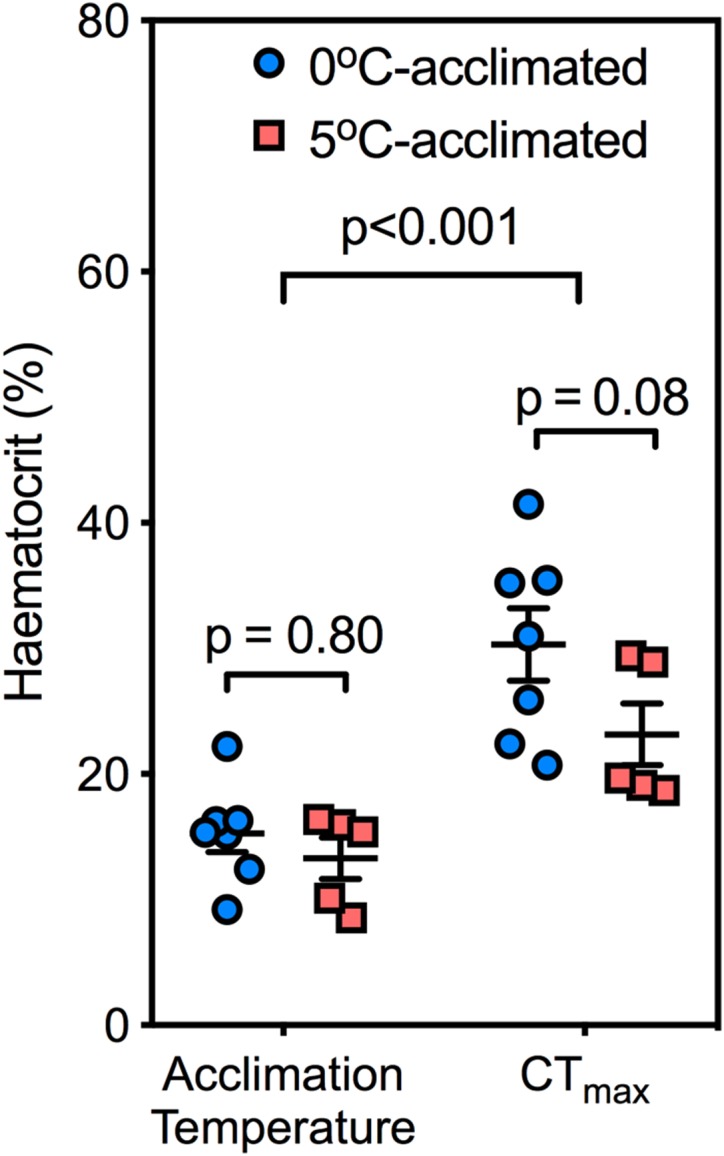
The effects of 0 and 5°C acclimation (6–9.5 weeks) on haematocrit at acclimation temperature and upon reaching CTmax. Significant differences were investigated with a two-way ANOVA. Data are mean ± SEM and individual data points